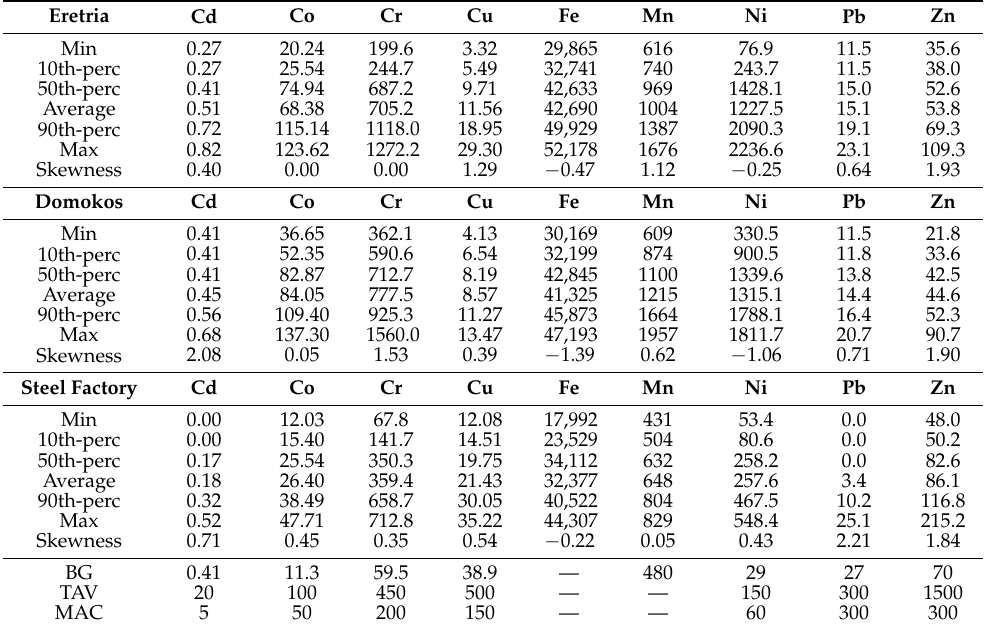
Table 2. Descriptive statistics of pseudo-total concentrations of potentially toxic elements (mg kg − 1 ) in soil samples from Eretria, Domokos and the steel factory in the industrial area of Volos.